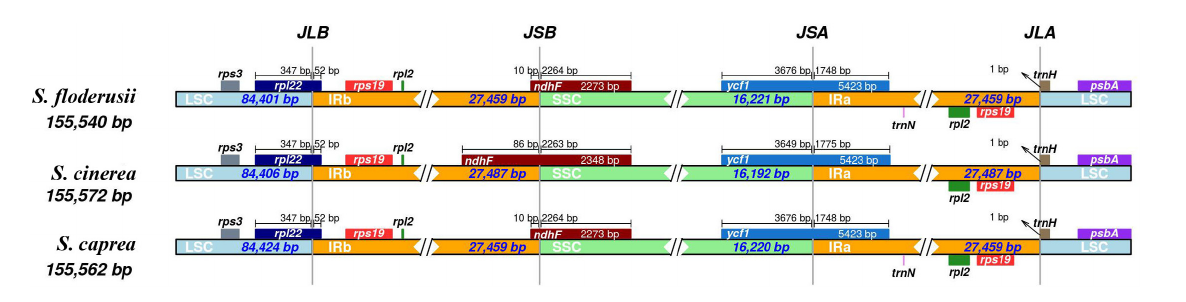
FIGURE4 Comparison of the border pattern of large single-copy (LSC) region, small single-copy (SSC) region, and an inverted repeat (IR) region among the S. floderusii , S. cinerea , and S. caprea cp genomes.